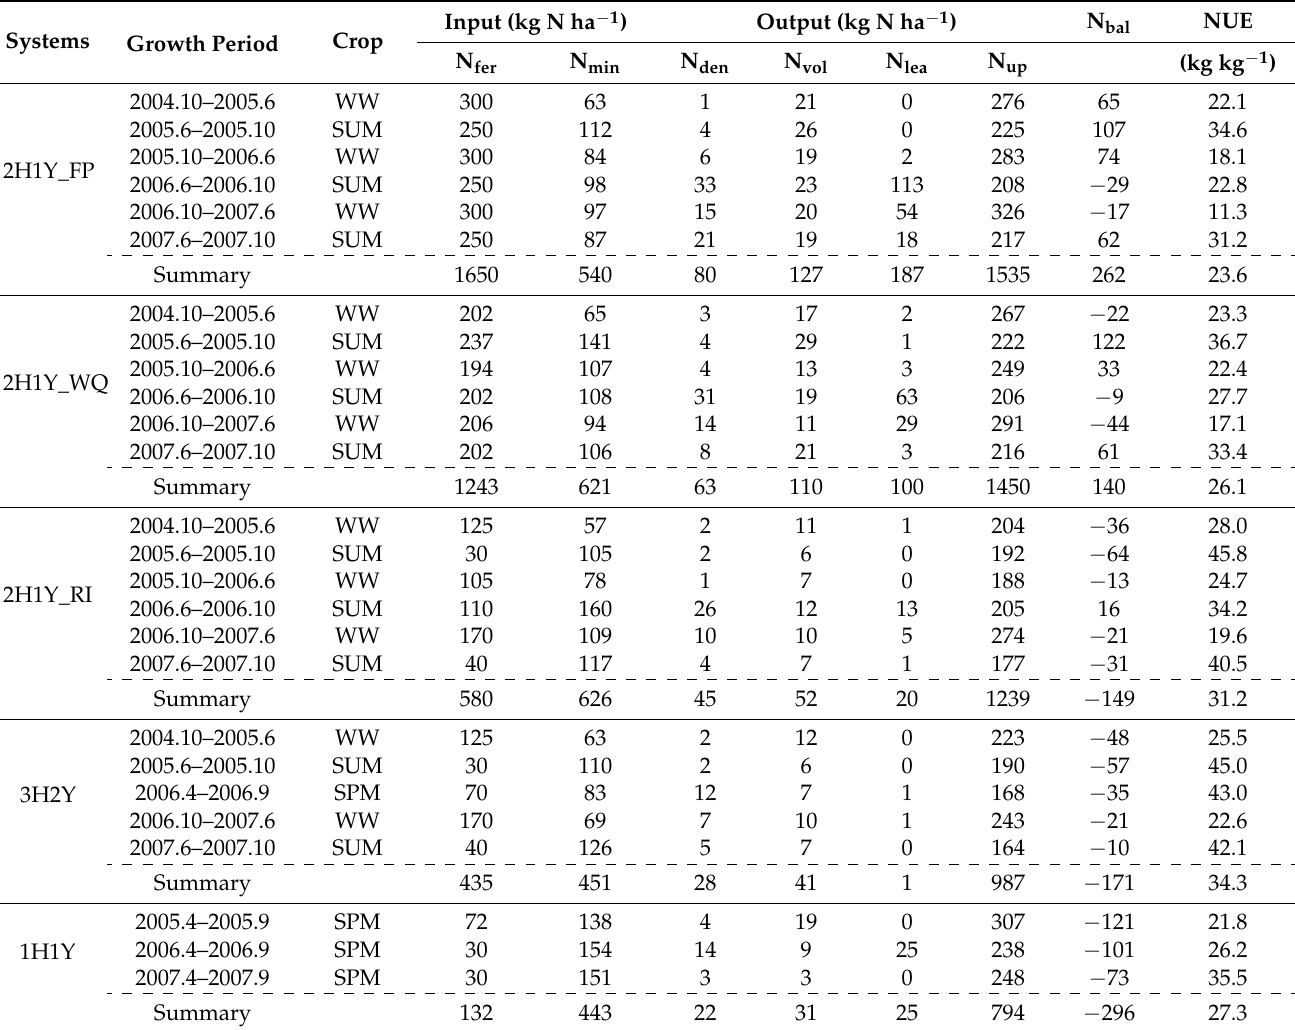
Table 6. Nitrogen fluxes of the 120cm soil profile simulated by the WHCNS model for 5